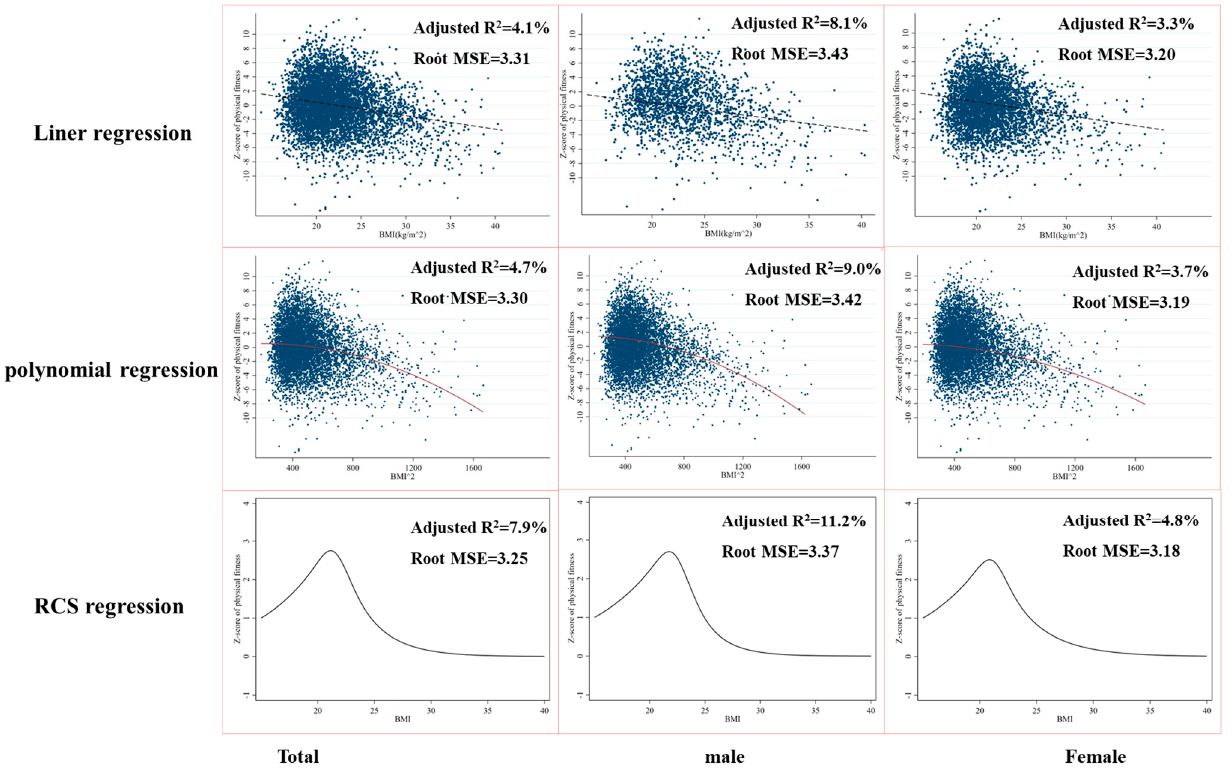
Figure 1. Linear regression, polynomial regression, and restricted cubic spines (RCS) analysis for BMI values and physical fitness z-score in college freshmen.